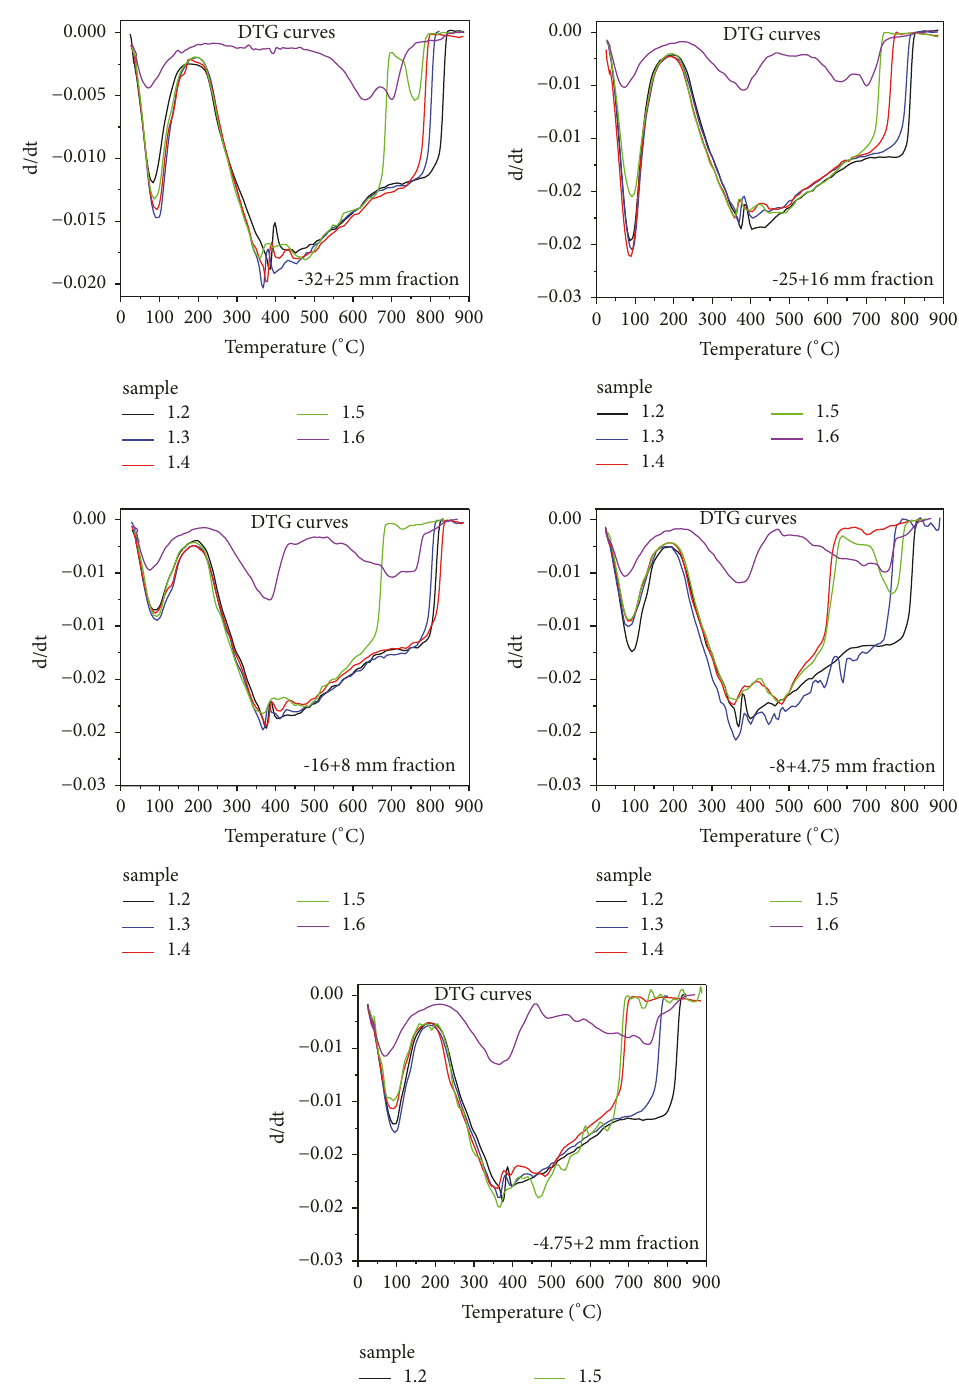
Figure 5: DTG curves of floated materials for all fractions at different specific gravities of medium.